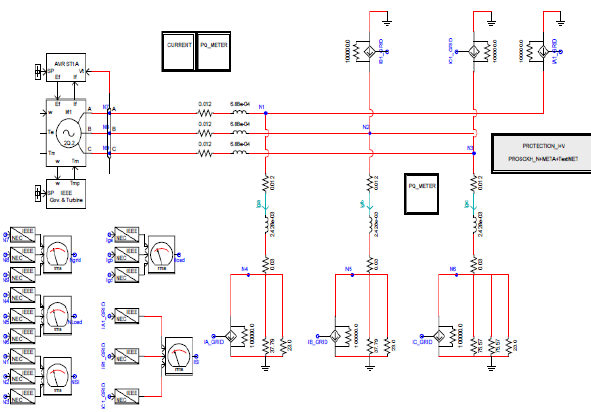
Figure 3. RSCAD/RTDS model during the PHIL test.